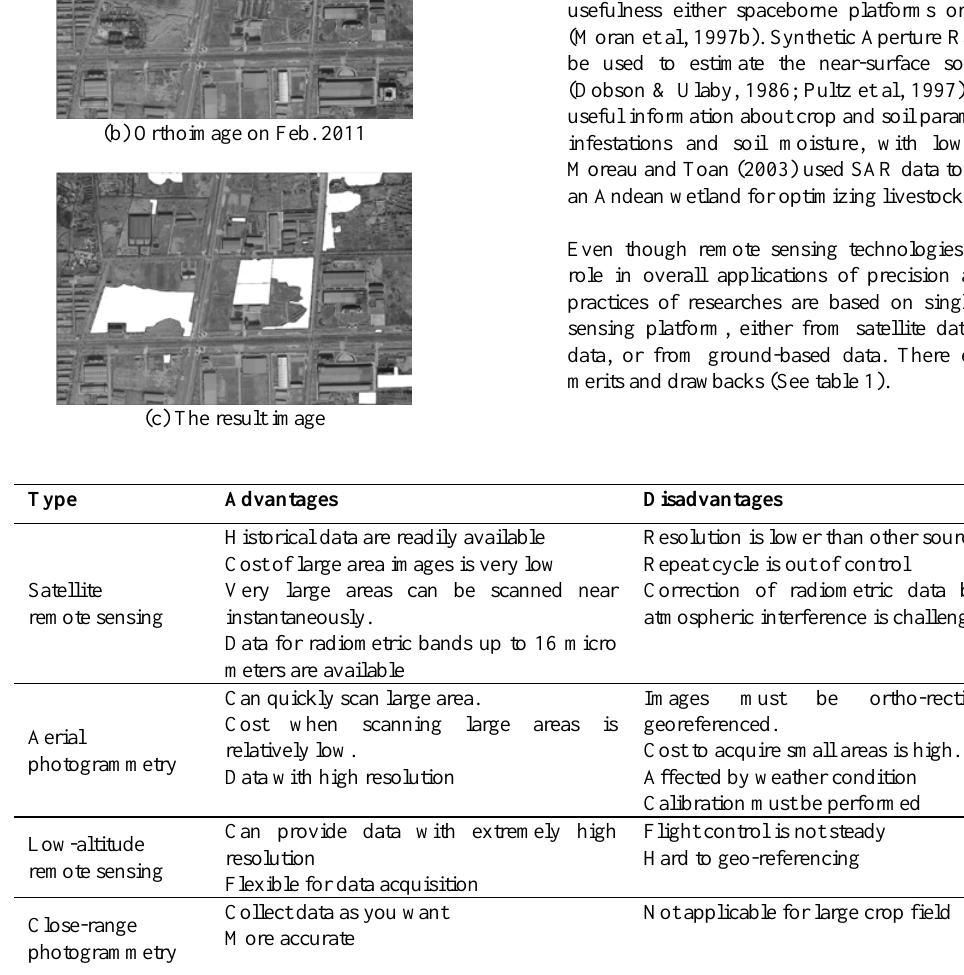
Figure 1. An example of change detection Besides the visible and near infra-red (NIR) portion, the microwave portion of the spectrum have already proven its usefulness either spaceborne platforms or airborne platforms (Moran et al, 1997b). Synthetic Aperture Radar (SAR) data can be used to estimate the near-surface soil moisture content (Dobson & Ulaby, 1986; Pultz et al, 1997), it also can provide useful information about crop and soil parameters, such as weed infestations and soil moisture, with low spatial resolution. Moreau and Toan (2003) used SAR data to quantify biomass in an Andean wetland for optimizing livestock management.